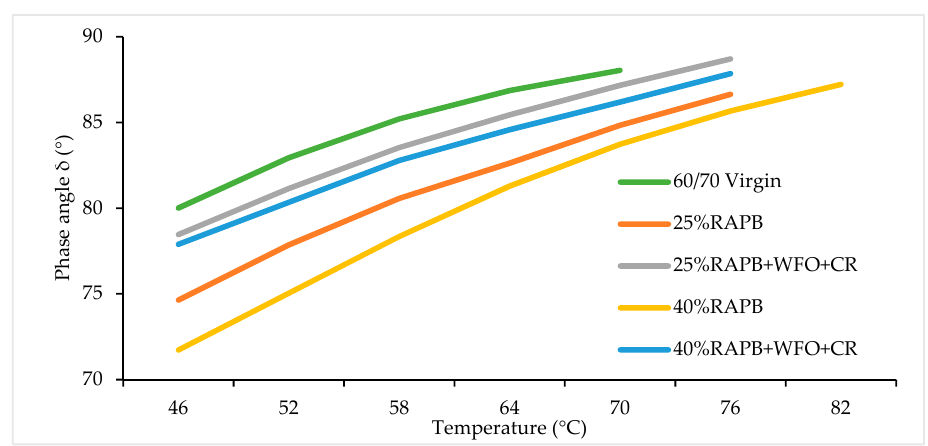
Figure 13. Phase angle result of the virgin, RAPB, and recycled asphalt binders.